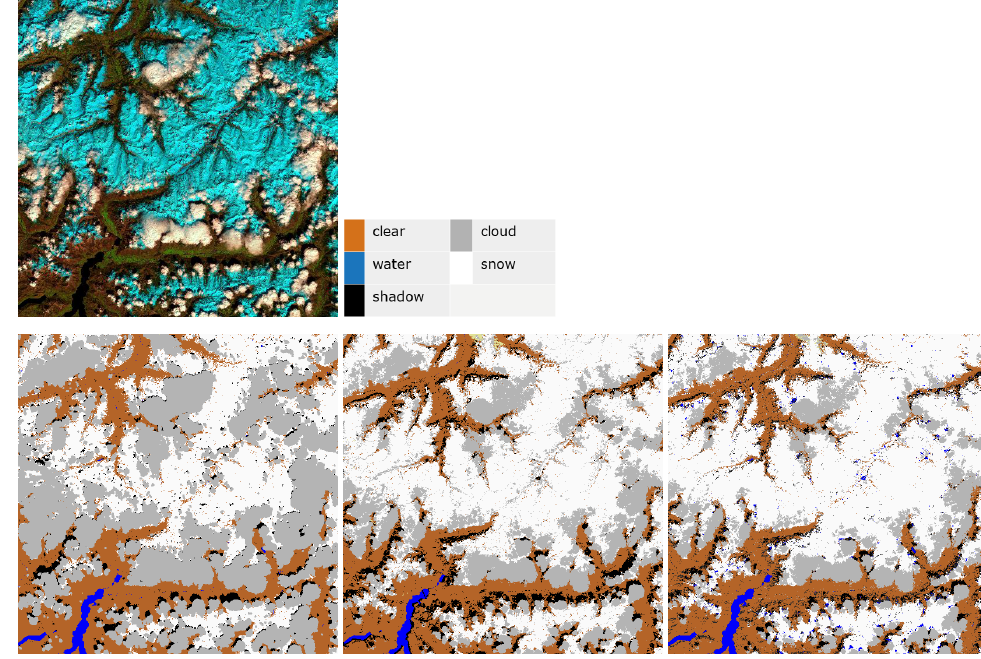
Figure 7. Top row: SWIR1/NIR/red composite of scene ID 19 (Davos). Bottom row (left to right): Fmask, ATCOR and Sen2Cor classification